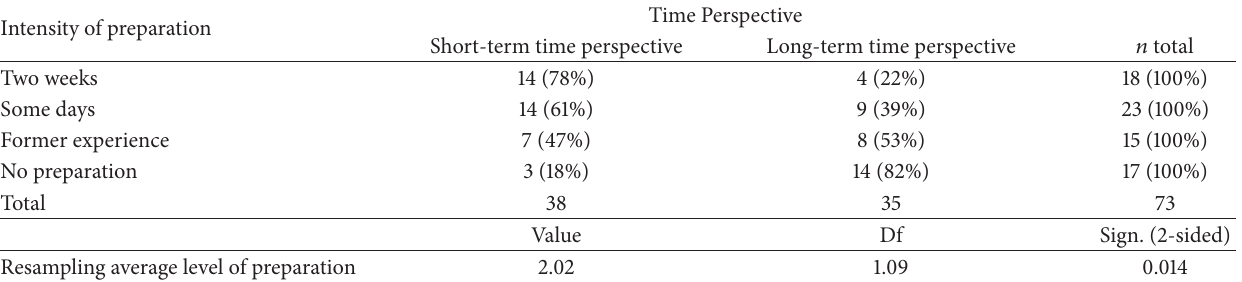
Table 9: The relation between time perspective and intensity of preparation ( 𝑛 = 73